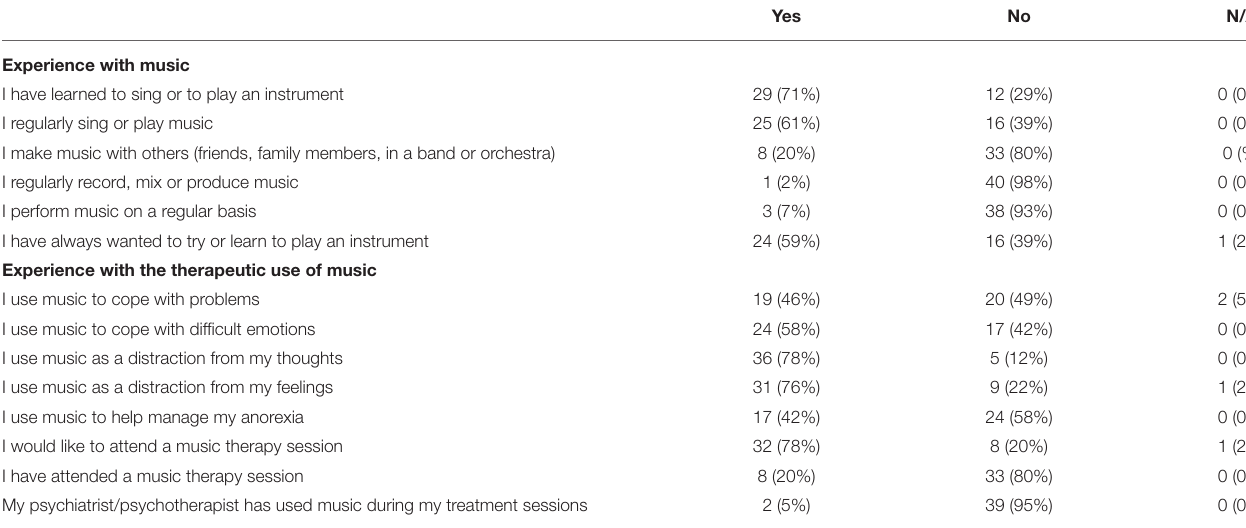
TABLE 2 | Answers to dichotomous questions regarding participants’ experience with music and the therapeutic use of music.